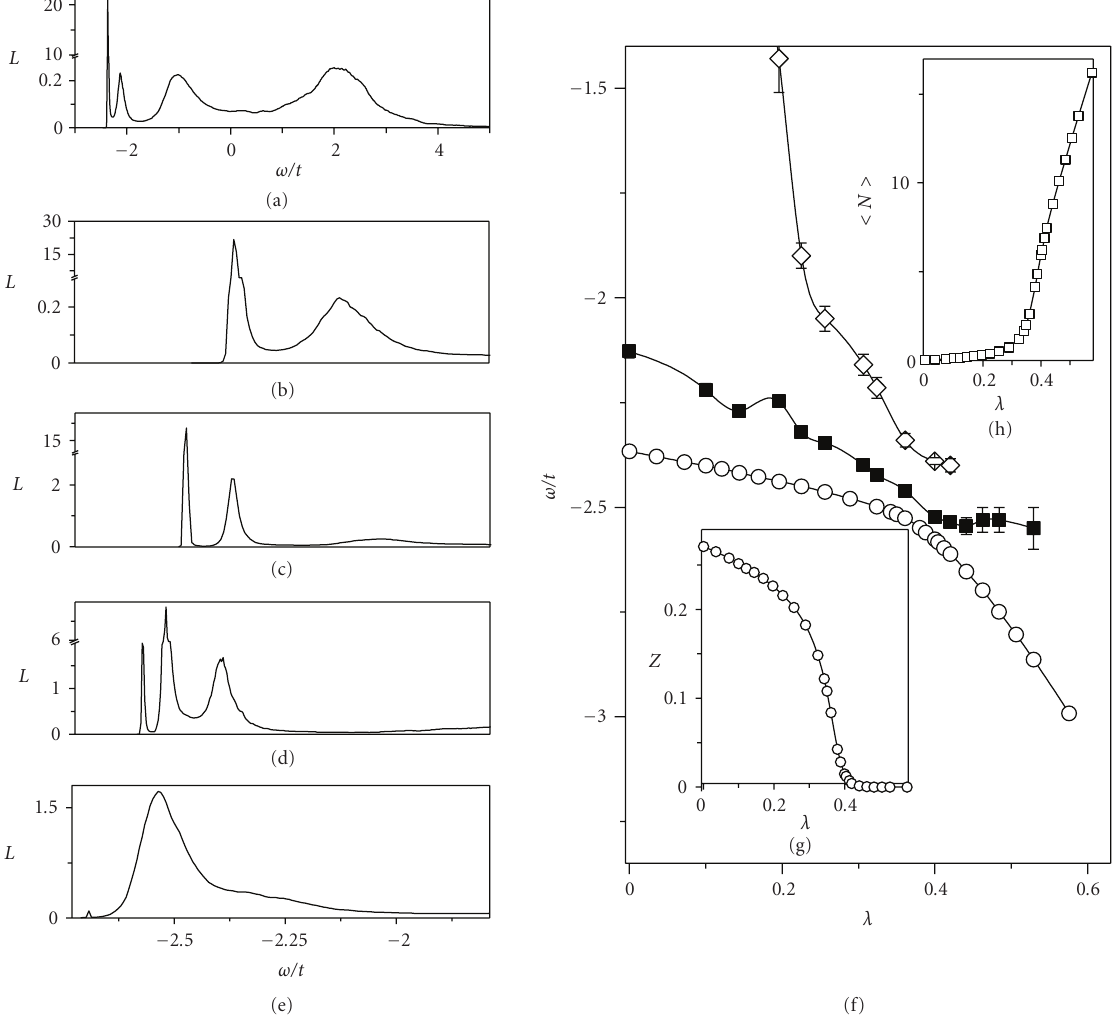
Figure 3: (a) Lehmann spectral function L of the ground state at k = ( π/ 2, π ,2) for J/t = 0 . 3 and λ = 0. Low-energy spectral function L in the ground state k = ( π/ 2, π ,2) at J/t = 0 . 3: (b) λ = 0; (c) λ = 0 . 3; (d) λ = 0 . 4; (e) λ = 0 . 46. λ -dependence at J/t = 0 . 3: (f) energies of the lowest resonances; (g) Z -factor of the lowest resonance; (h) average number of